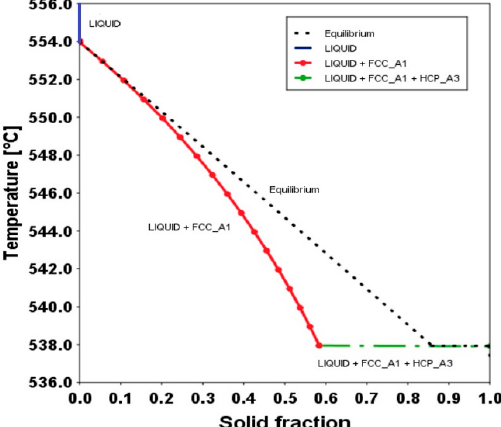
Figure 11. Scheil solidification diagram showing solid fraction versus temperature.